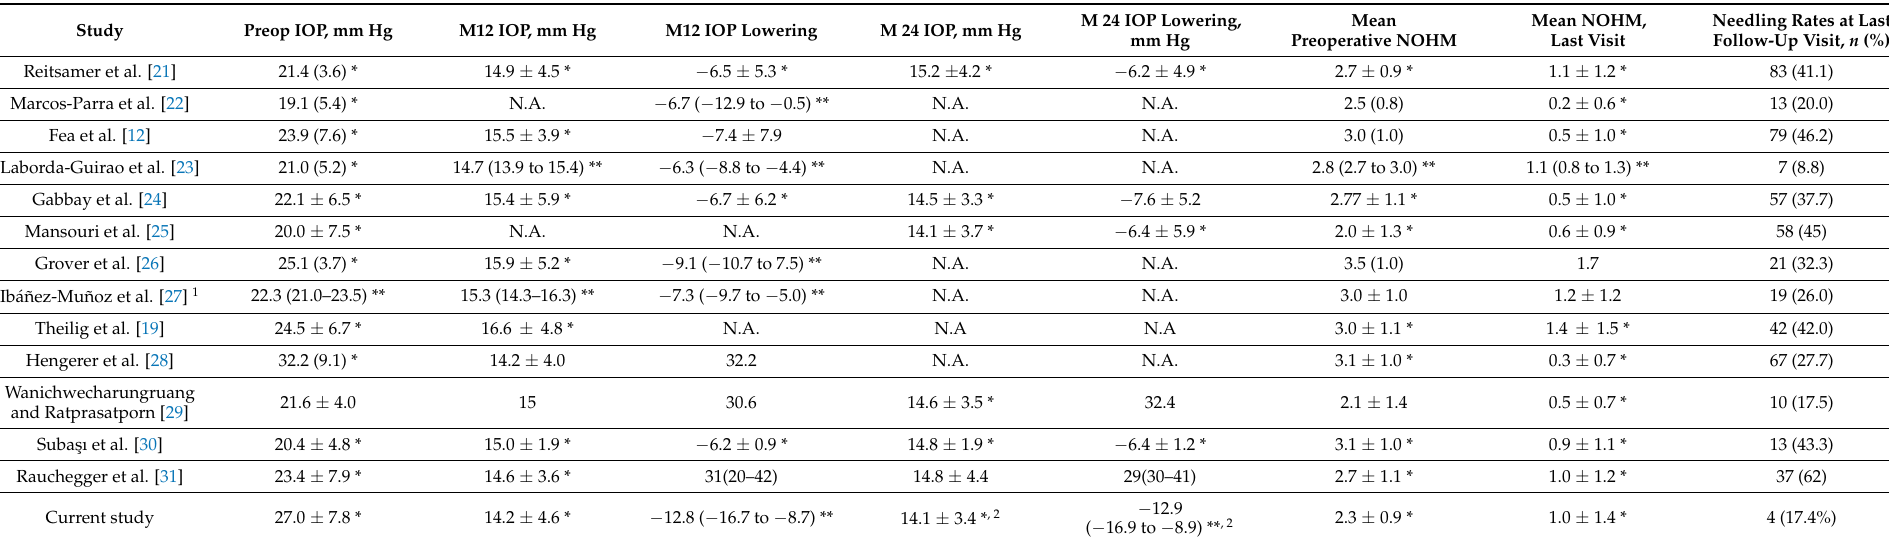
Table 5. A comparison of the clinical outcomes between the current study and the available